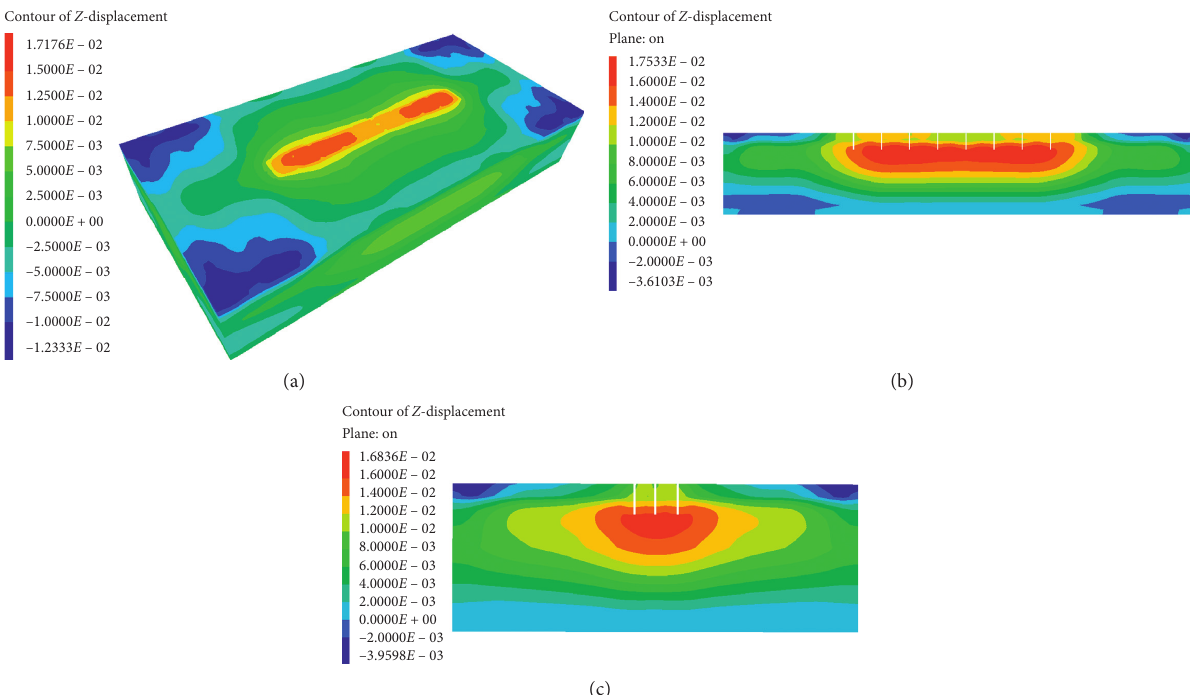
Figure 25: Group wells subsidence nephogram after the first drawdown (unit: m). (a) Three-dimensional diagram. (b) Cross section of the well midpoint. (c) Longitudinal section of the well midpoint.